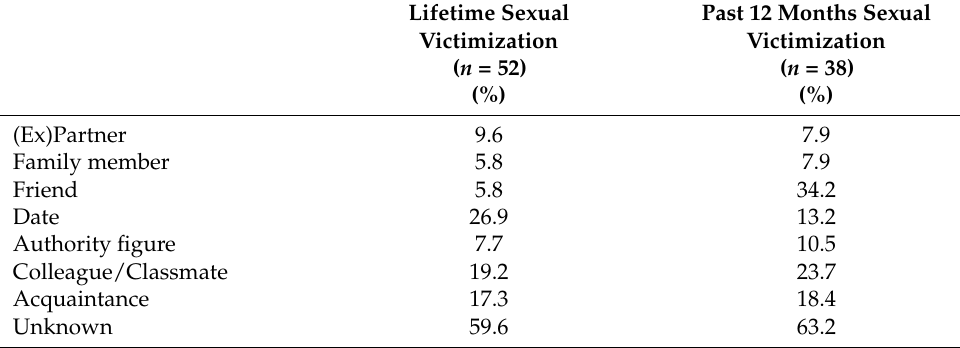
Table 5. Relationship to the assailant of sexual